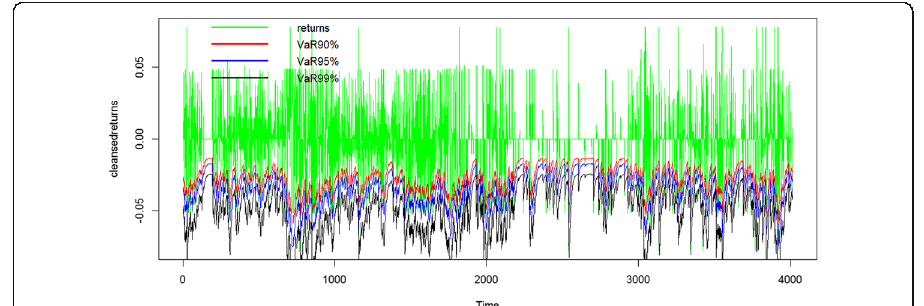
Table 8 VaR violation of cleansed Total Nigeria Plc returns Model VaR alpha No. of Violation Ratio Percentage sGARCH(1,1) with normal